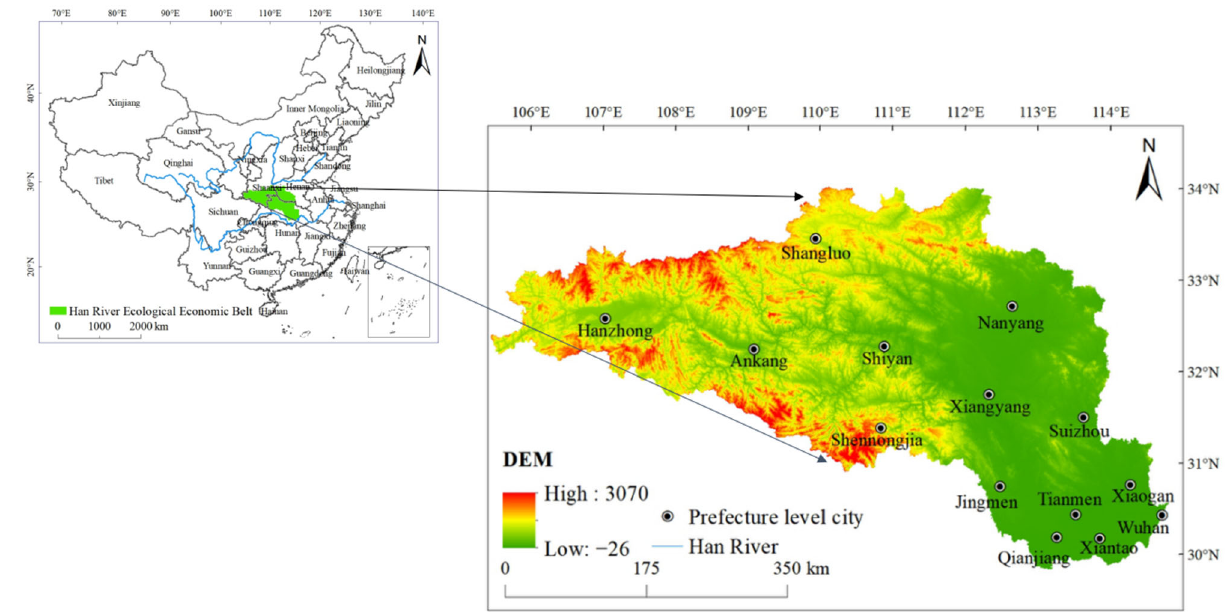
Figure 1. Location of HREEB in China.